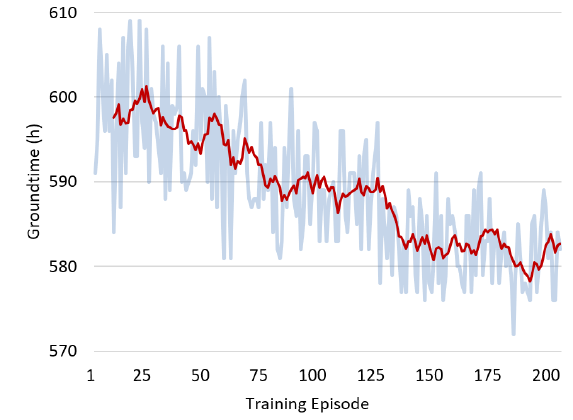
Figure 8. Evolution of the ground time KPI during training (in blue) with a moving average trend line (in red).